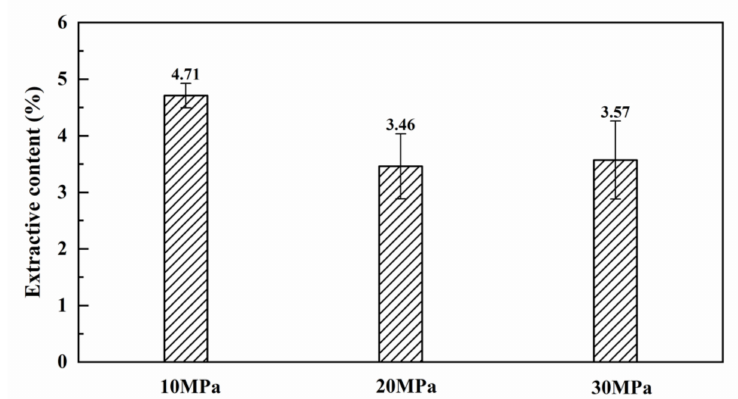
Figure 7. Extract yields of specimens of wood after 1 h of SCD at di ff erent pressures.